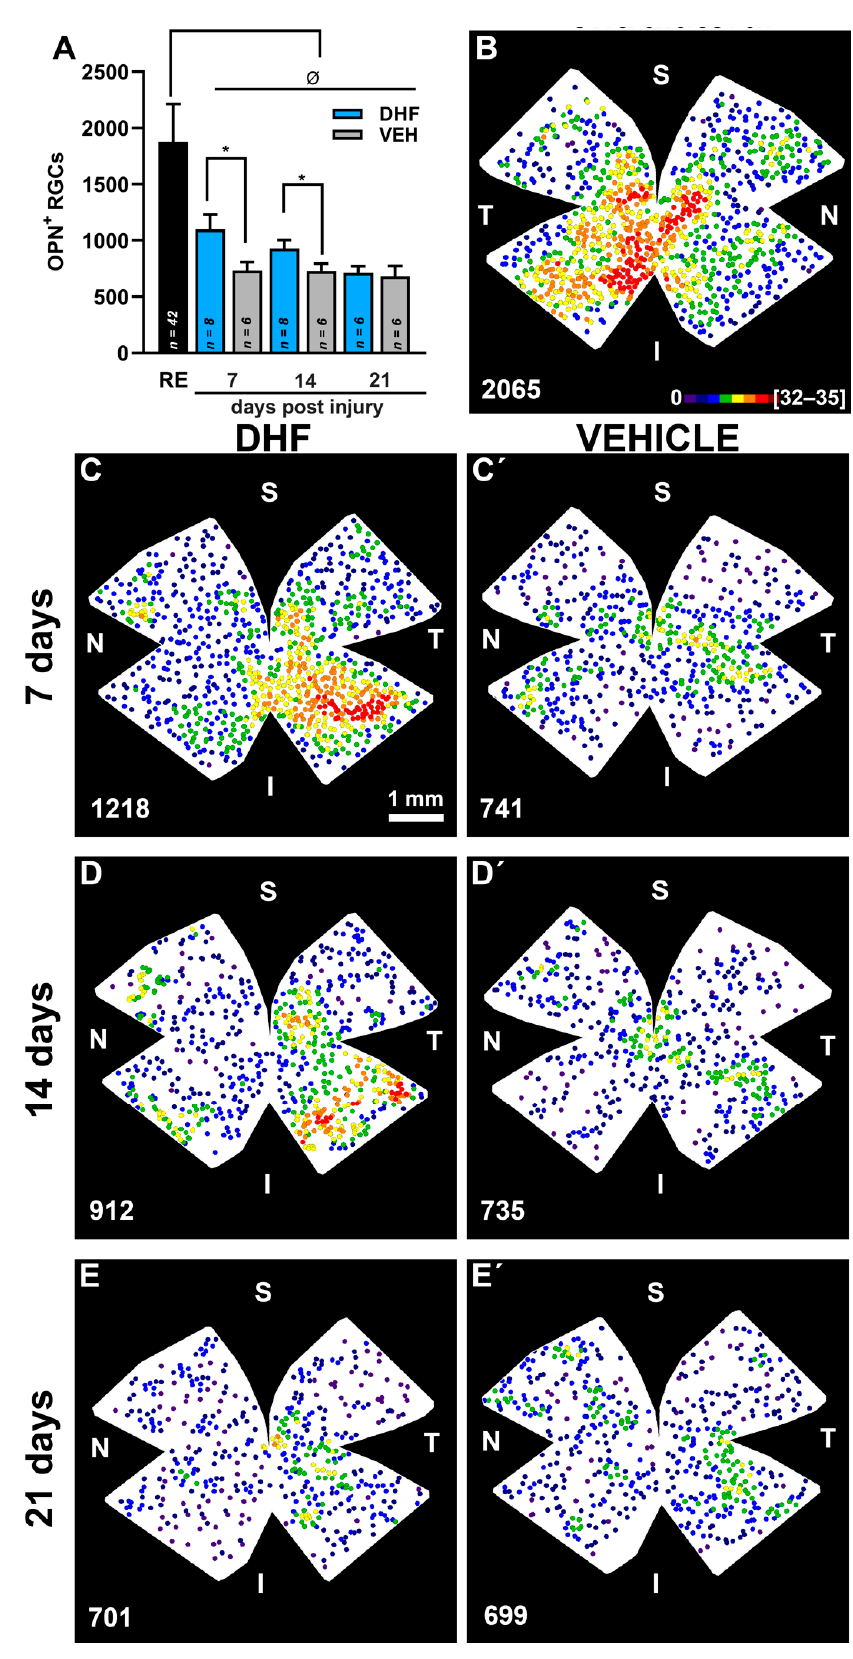
Figure 6. DHF prevents IONT-induced OPN + RGC loss. In adult albino rats, the left optic nerve was intraorbitally transected and animals were treated i.p. daily with vehicle (VEH) (1% DMSO in 0.9% NaCl) or DHF (5 mg/kg) starting from one